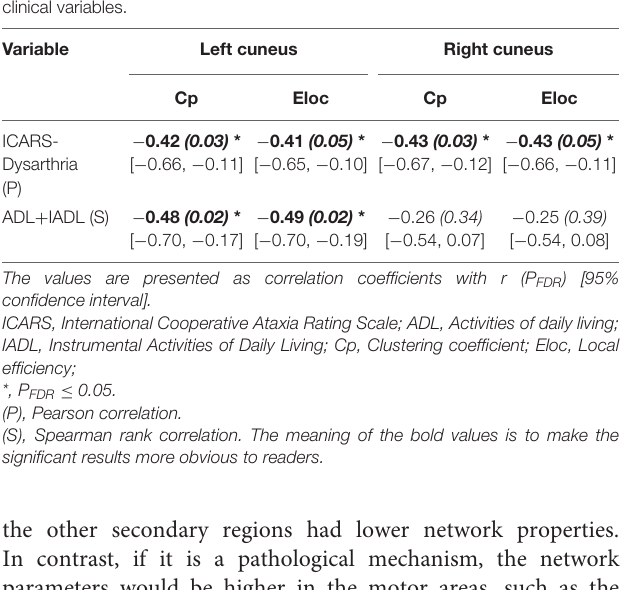
Frontiers in Aging Neuroscience |